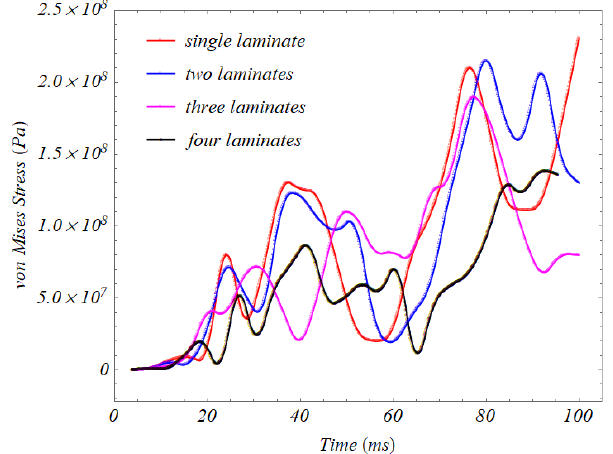
Fig. 18. von Mises stress against time for various number of cellphone casing laminates at 1500 mm drop distance.